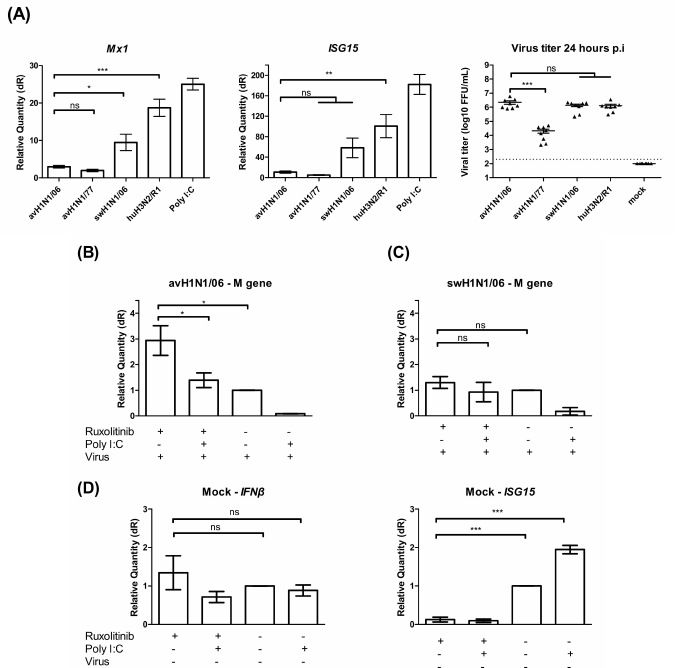
Figure 4. Innate immune response in swALI after IAV infection. ( A ) Relative quantity of Mx1 , ISG15 genes on swALI after IAV infection. swALI were infected or Poly (I:C) pretreated for 2 h from the apical surface. On 24 h post-infection, the messenger RNA from each group was used to perform quantitative real-time PCR. Mx1 and ISG15 genes were normalized to β -actin expression. Calculation of 2 − ∆∆ CT method was normalized to mock infected groups. Results showed avH1N1 viruses represented as weak inducers for ISGs . ( n = 8 total samples from three individual